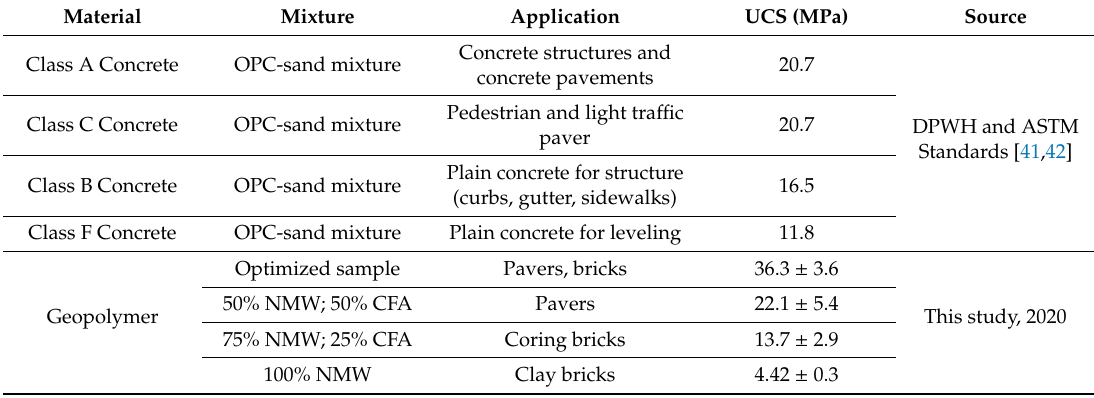
Table 10. Comparison of unconfined compressive strength from the standard materials.